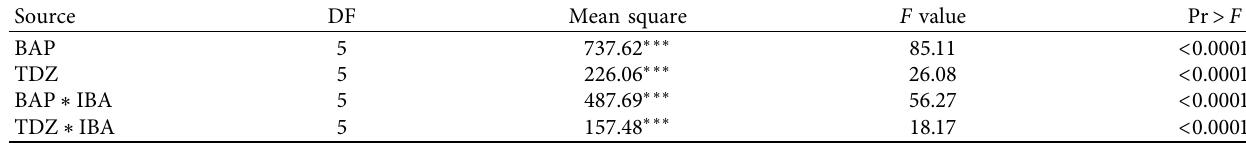
Table 5: ANOVA summary of effect of BAP, TDZ, BAP ∗ IBA, and TDZ ∗ IBA on in vitro plantlet regeneration of A. corrorima . Source